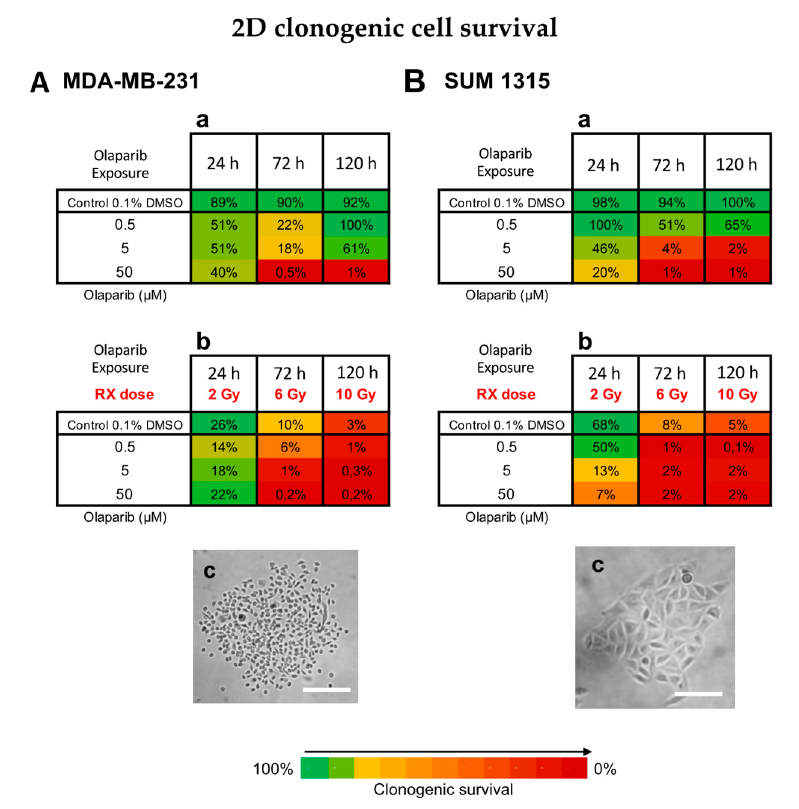
Figure 3. Clonogenic cell survival of MDA-MB-231 ( A ) and SUM1315 ( B ) cell lines cultured in monolayer, after a treatment with 0.5, 5 and 50 µM Olaparib alone for 24 h, 72 h, or 120 h ( a ), or combined with fractioned irradiation of 2, 6 or 10 Gy (“Rx dose”) ( b ). For each treatment condition, the percentage of the clonogenic survival was determined by the ratio of the survival fraction of treated cells on the survival fraction of 0.1% DMSO control cells. Results are represented on a Heatmap. Standard errors are < 10% for every treatment condition ( n > 3). ( c ) Photographs of clonogenic populations of MDA-MB-231 and SUM1315, Magnification = 40 X, scale bar = 50 µm.